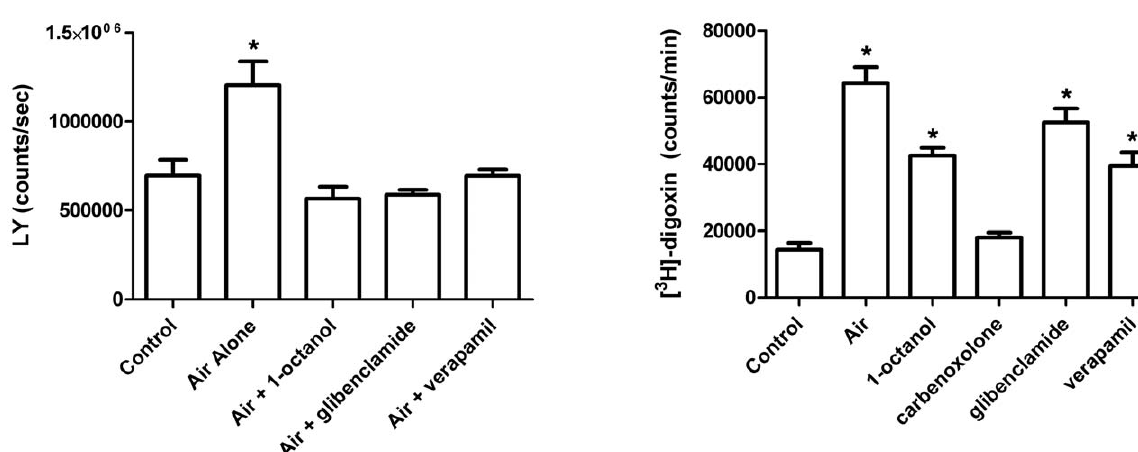
Figure 5. Assessment of MDR1 transporter involvement in air- stimulated ATP release. Exclusion of a radiolabeled substrate of the MDR1 ABC transporter was measured to determine whether activity of this transporter is increased during air-stimulated ATP release. Note that this transporter acts to exclude substrates, so an increase in [ 3 H]-digoxin uptake reflects an inhibition of transporter activity. Confluent NHEK cultures were pre-incubated with ATP release inhibitors using the same protocol as for the pharmacological analysis assays. [ 3 H]-digoxin (50 nM final concentration) was added in the media after air exposure or a change of half the media (control). After 7 minutes, the time of peak air- stimulated ATP release, [ 3 H]-digoxin levels in cell lysates were measured. Air exposure significantly increased [ 3 H]-digoxin uptake, as did the ABC transporter inhibitors glibenclamide and verapamil. The connexin blocker 1-octanol also significantly inhibited uptake, while the other connexin blocker carbenoxolone was without effect. The inhibition of MDR1 following air exposure, combined with the disparate effects of ATP release inhibitors, indicates that this transporter is not involved in air-stimulated ATP release. Values represent 6 wells per group + / 2 SEM, * p , 0.05 vs. control.